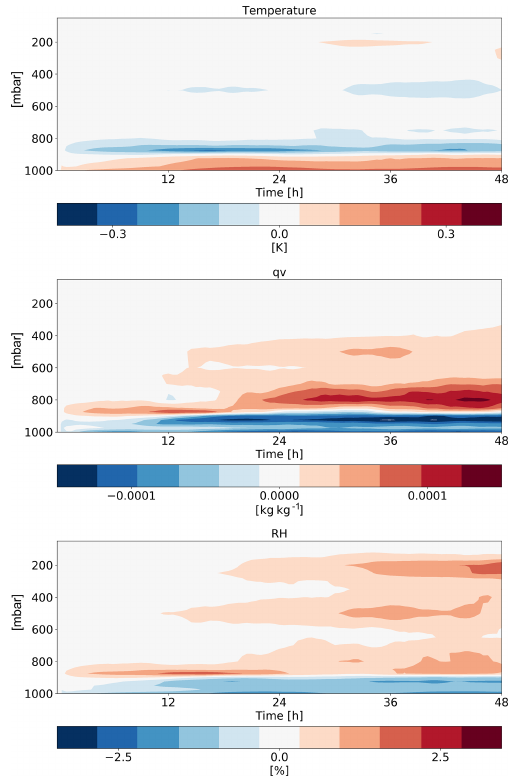
Figure 10. Time–height diagrams of the differences in the domain- mean temperature, specific humidity (qv) and relative humid- ity (RH) vertical profiles between polluted (CDNC = 200cm − 3 ) and clean (CDNC = 20cm − 3 ) simulations for the shallow-cloud- dominated case (10–12 August 2016).